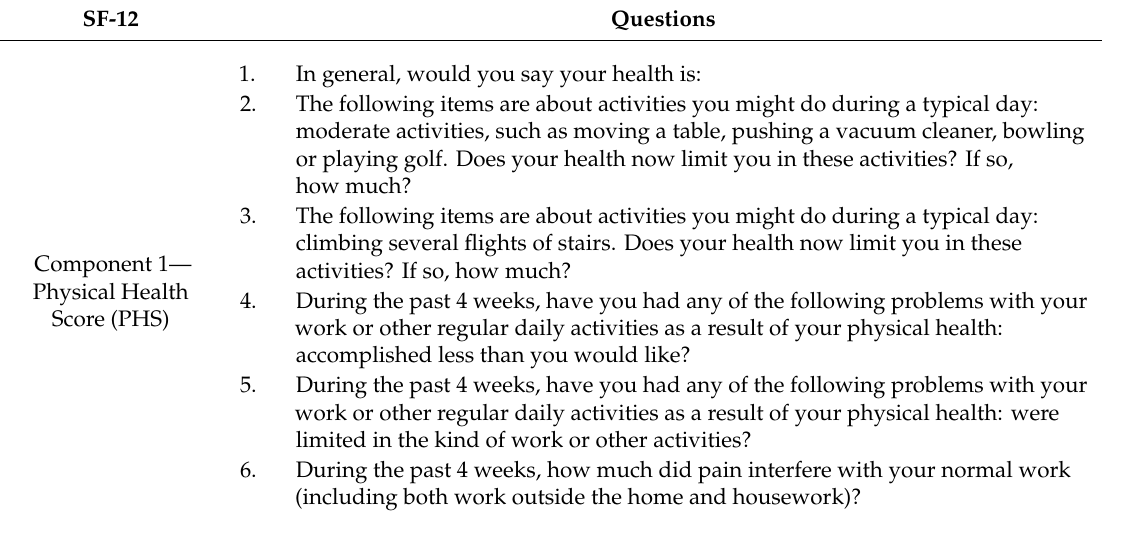
Table A1. Physical Health Summary (PHS) and Mental Health Summary (MHS) of General Health SF-12.